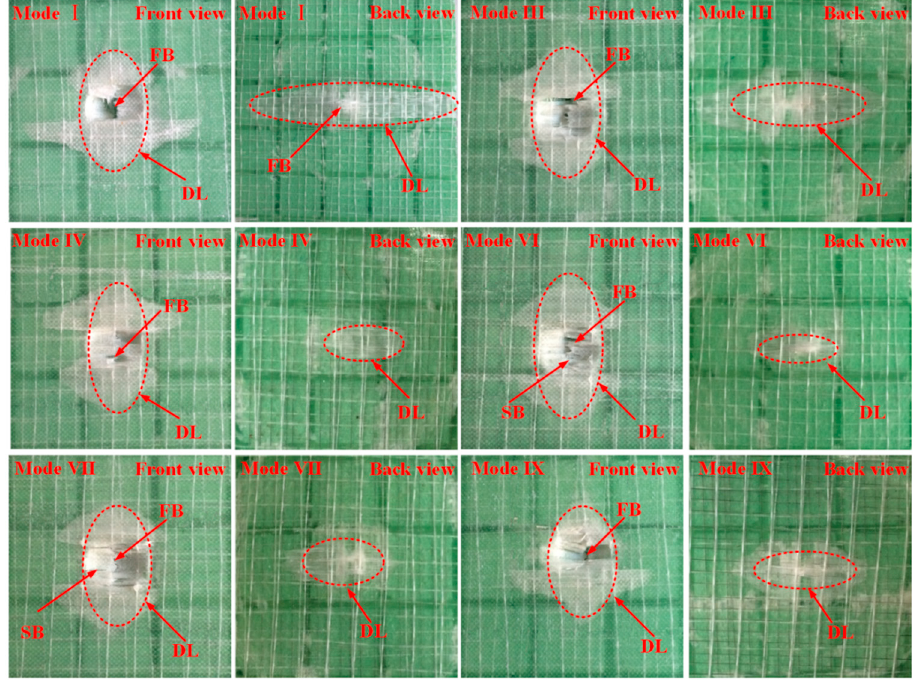
Figure 4. Representative damaged sandwich panels in front and back views. Notes: except the figure back view of Mode I, other figures present the center 60 × 60 mm 2 region of impacted sandwich panels. DL indicates delamination, FB represents fiber breaking and SB stands for SMA wire breaking.